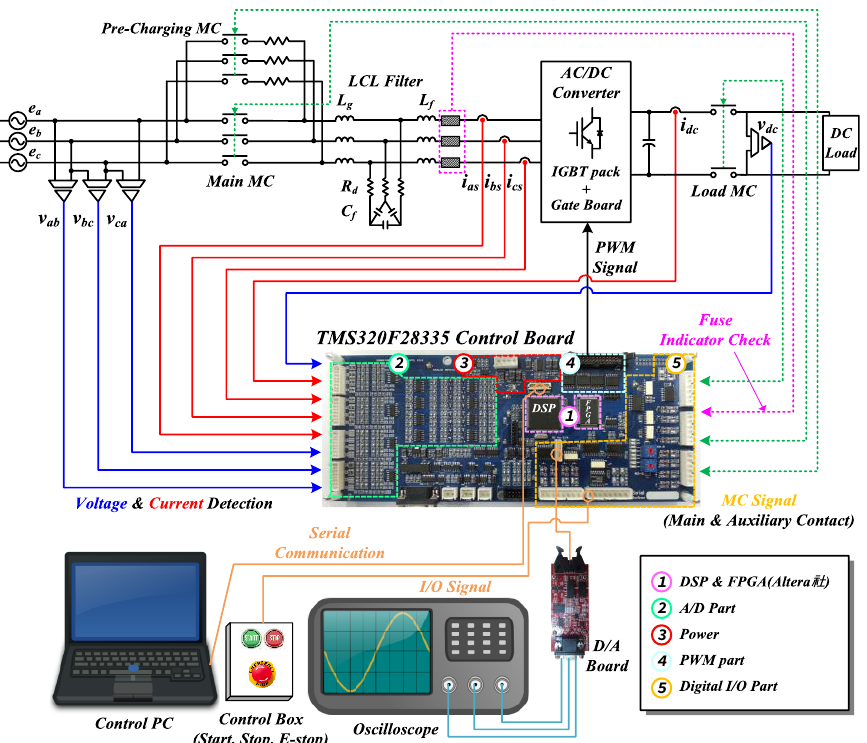
Figure 22. Configuration of the experiment system. MC: Magnetic Contactor.